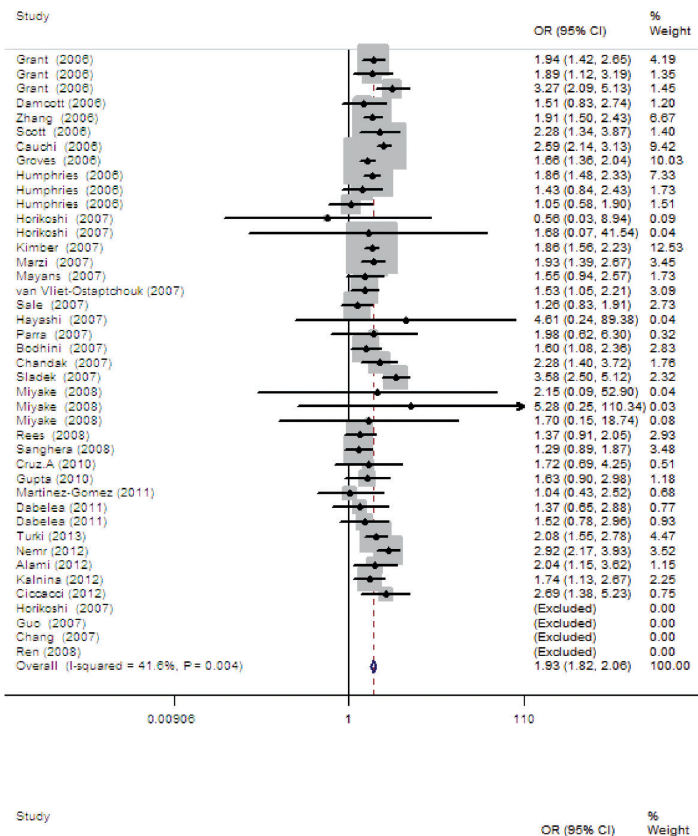
Figure 3. Meta-analysis of the associa- tion between type 2 diabetes and the GT genotype of